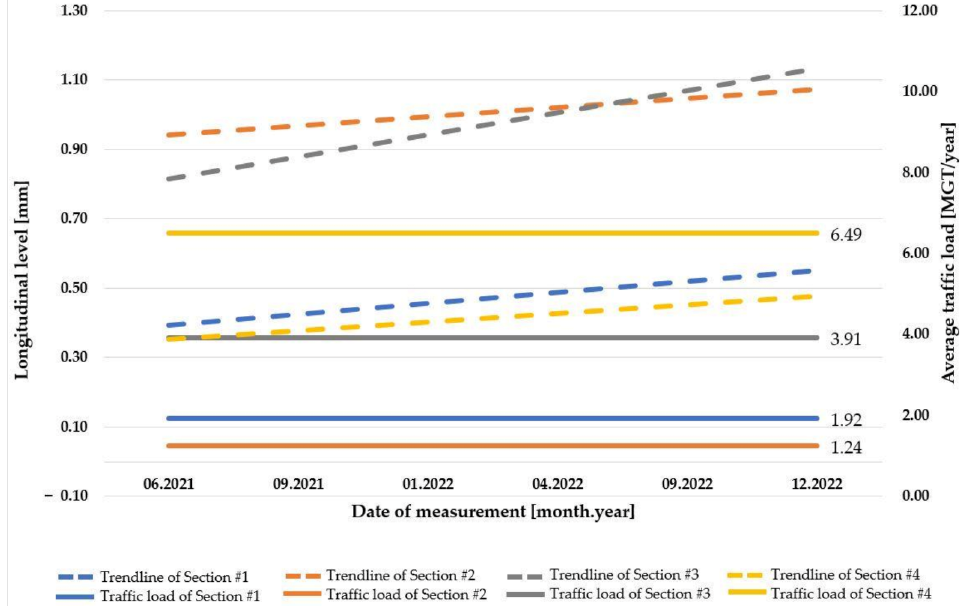
Figure 26. The relationship between longitudinal level and traffic load in ballasted track